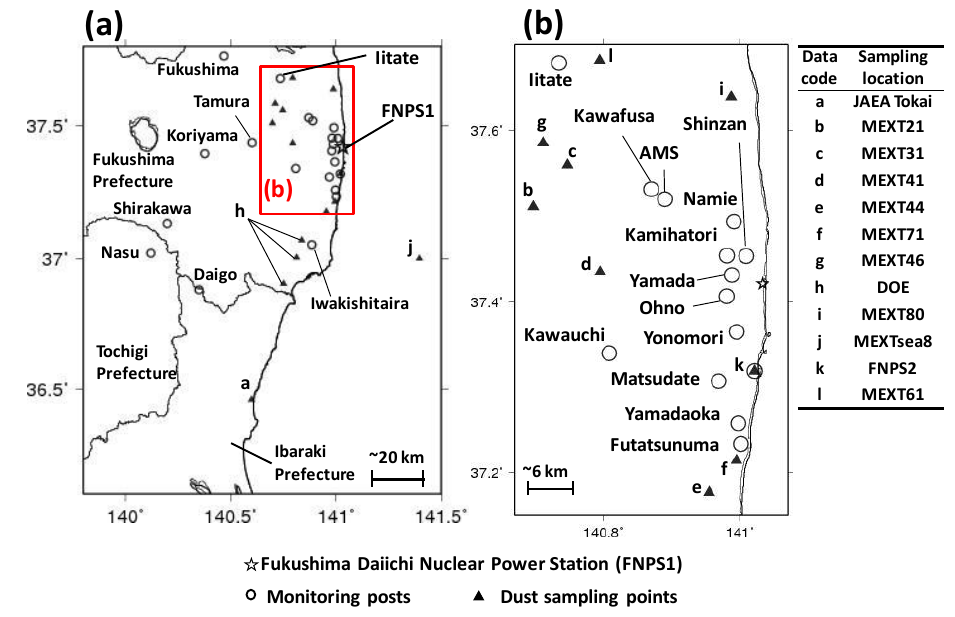
Figure 2. The sampling locations of the environmental monitoring data over the land used for the source term